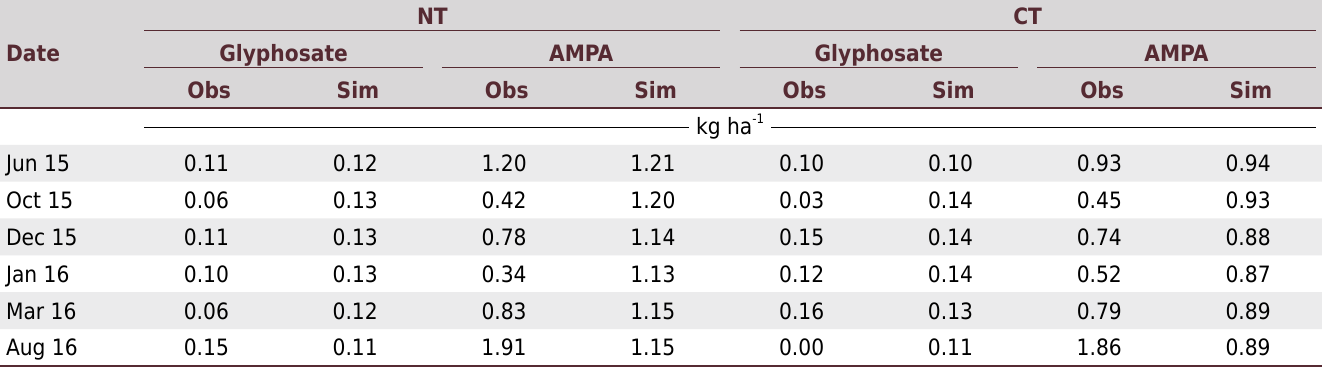
Table 3. Total mass of glyphosate and AMPA during the crop cycle for no-tillage (NT) and conventional tillage (CT) observed (Obs) and simulated with time-variable hydraulic properties (Sim)